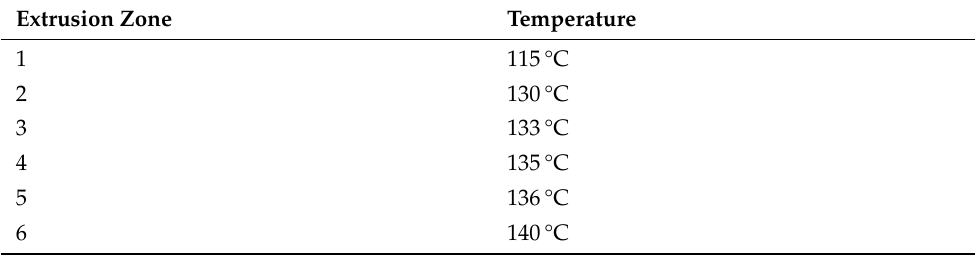
Table 7. Extrusion temperature profile for the extruder-screw. The entire screw is temperature controlled in each segment/zone separately. The matrix material B, PLA Ingeo 6302 D. Ingeo 6302D has T g between 55°C and 65°C and T m between 125°C and 135°C. Extrusion